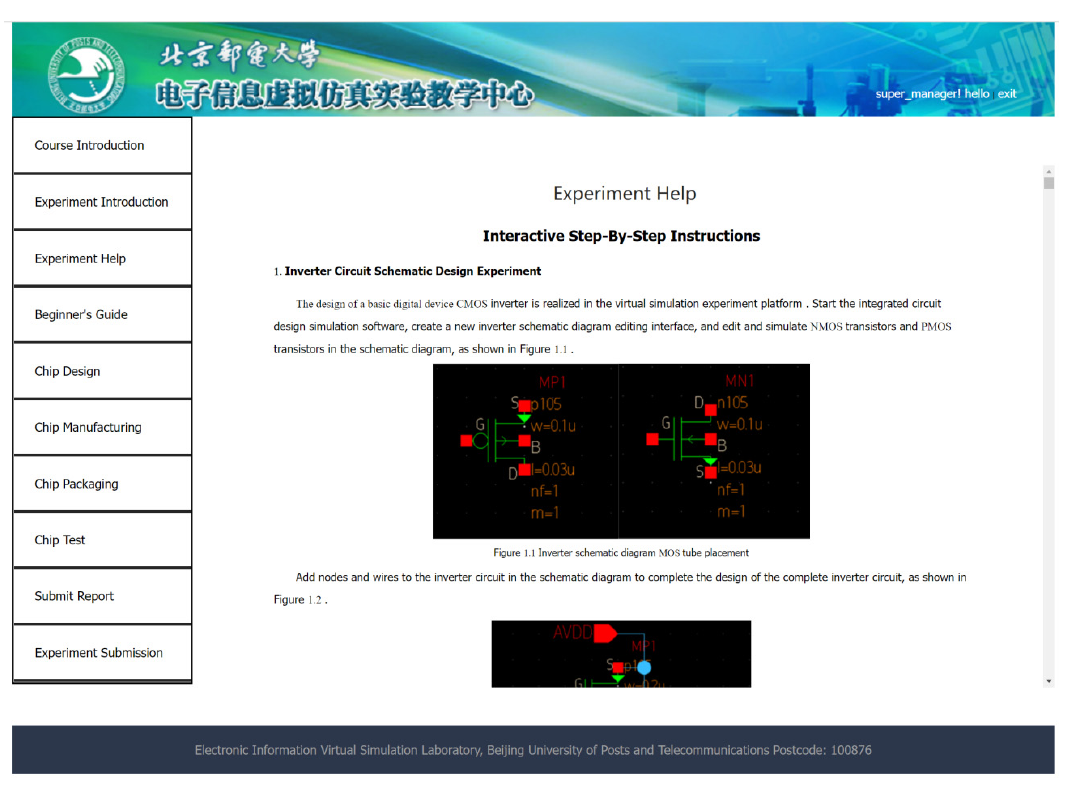
Figure 17. Front page of website. The non-English part is the emblem, name or the website title of BUPT.